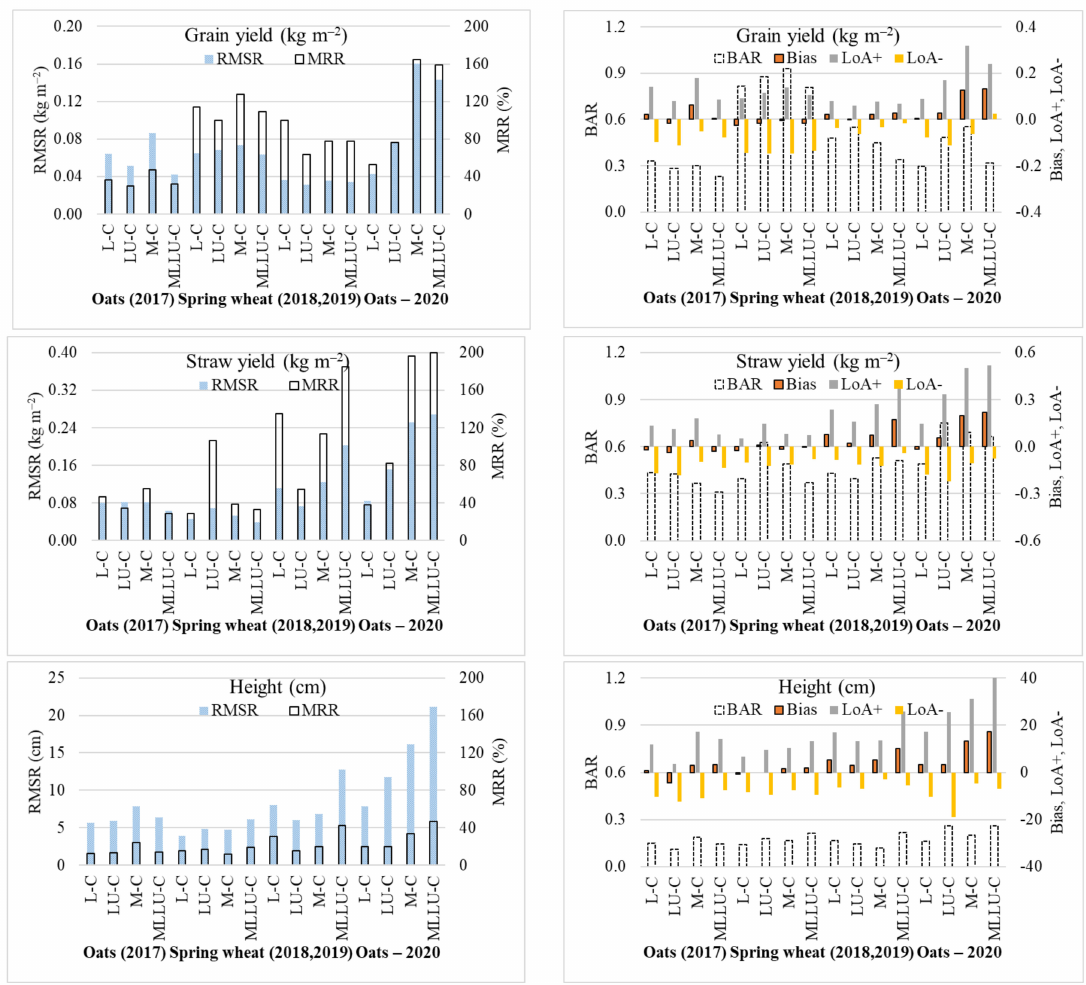
Figure 6. Root mean square residuals (RMSR) and maximum relative residuals (MRR), which are the difference in the yield trait components between the particular SICS and control plots, BAR—Bland–Altman ratio, Bias—mean of the differences, LoA—limit of agreements, SD—standard deviation of the